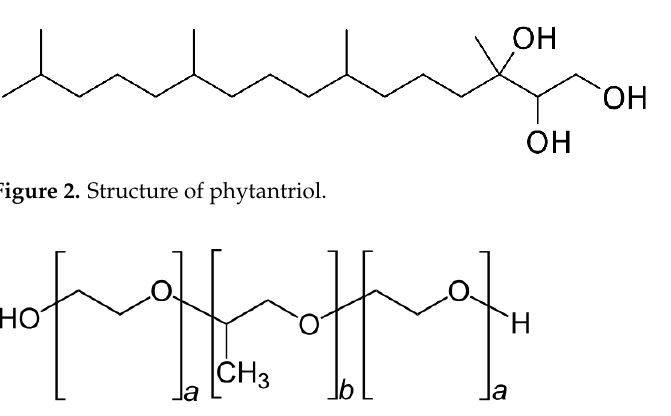
Figure 3. General structure of poloxamer (where poloxamer 407 has block lengths of a = 101 and b = 56).